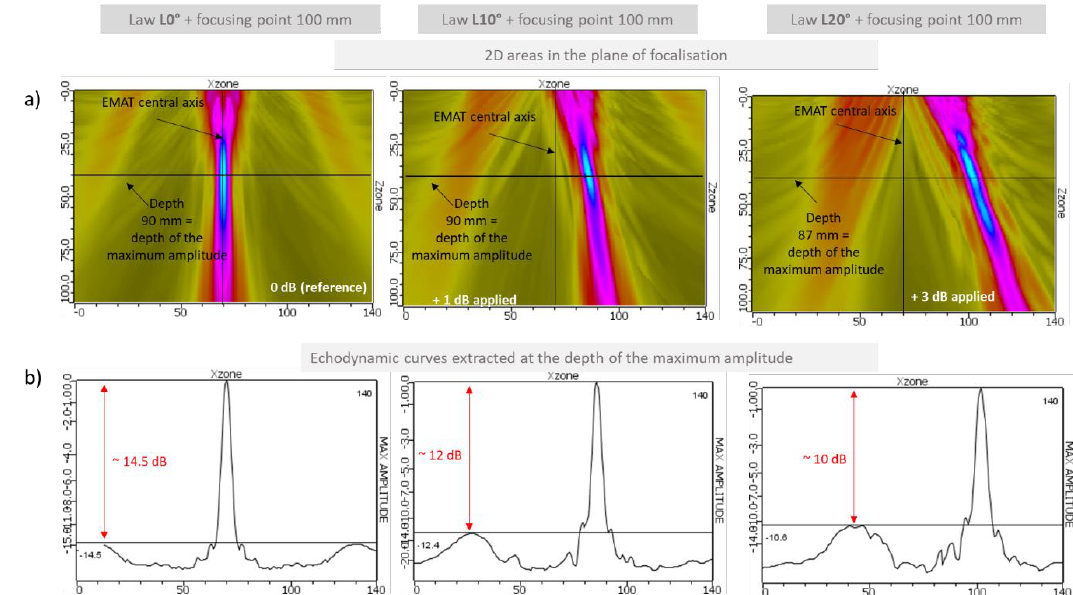
Figure 10. Simulation results. Longitudinal ultrasonic field radiated in 180 °C liquid sodium by the 12-element EMAT. Focusing law at 100 mm without deflection (left figure), with 10° deflection (middle figures) and with 20° deflection (right figure). Computation of the field in a 2D area located in the focal plane (figures a)) and amplitude of the field along a horizontal profile extracted from the 2D field ate the depth of the maximal amplitude (figures b)). Excitation signal at 1 MHz composed of 3 bursts (signal close to the experimental one used in Section 4).